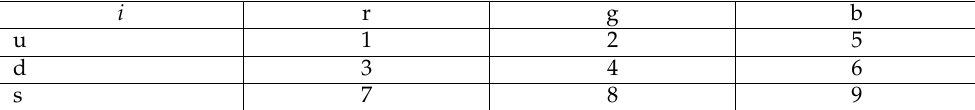
Table 3. Flavor and color combinations associated with Equations (21) and